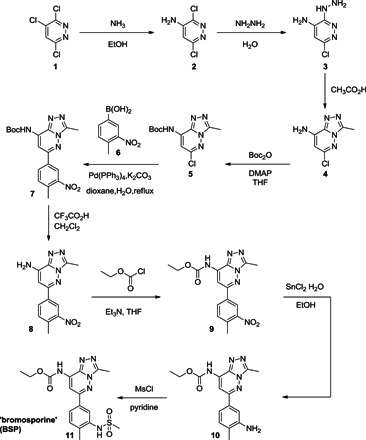
Synthesis of BSP.